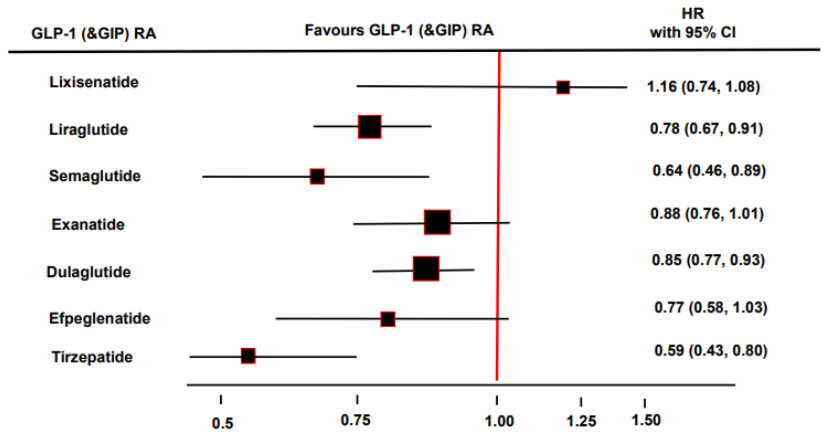
Figure 2. Renal endpoints of single glucagon-like peptide 1 (GLP-1) and dual GLP-1 and glucose- dependent insulinotropic polypeptide (GIP) receptor agonists (RA) [35,36,41,91,98–100].